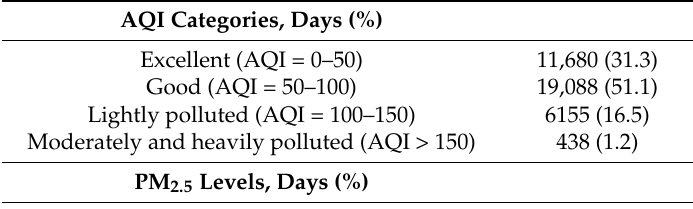
Table 3. Descriptive statistics of air quality 1 .